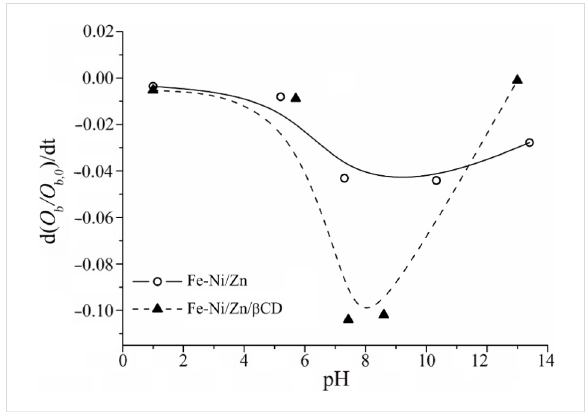
Figure 7: Obscuration curves for the Fe-Ni/Zn ( ○ ) and Fe-Ni/Zn/ β CD ( ▲ ) as a function of